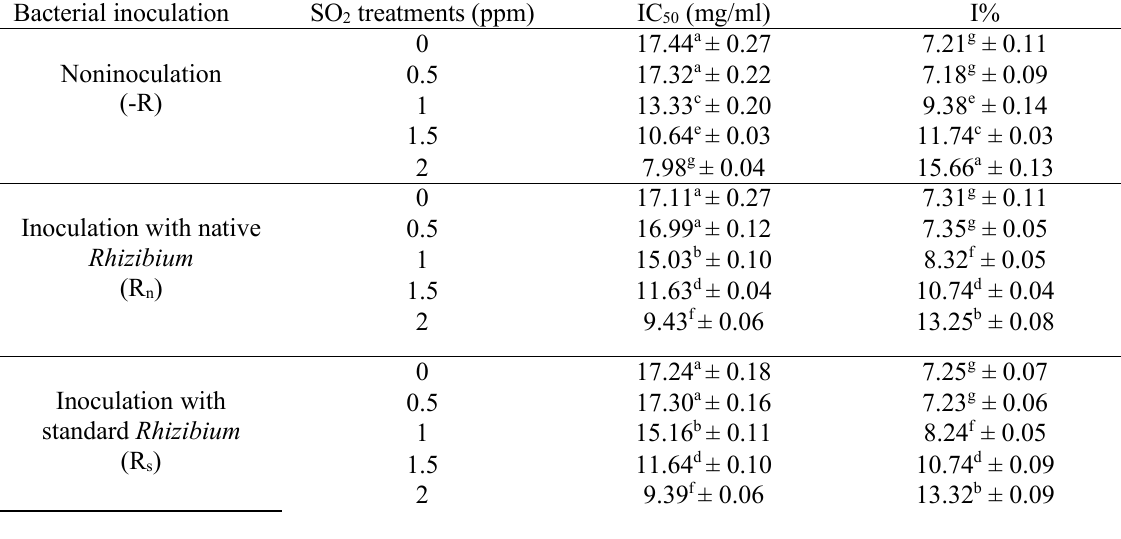
Table 1. Means comparison of interaction effect of bacterial inoculation (no-inoculation (-R), inoculation with native (R n ) and standard (R s ) Rhizobium meliloti) and SO 2 pollution (0, 0.5, 1, 1.5 and 2 ppm) on values of antioxidant capacities (IC 50 ) and antioxidant activities (I %) in 45 days plants. Similar words indicate not significantly different according to Duncan's test. The data are the means of three replicates ±SE and comparisons were performed separately for each